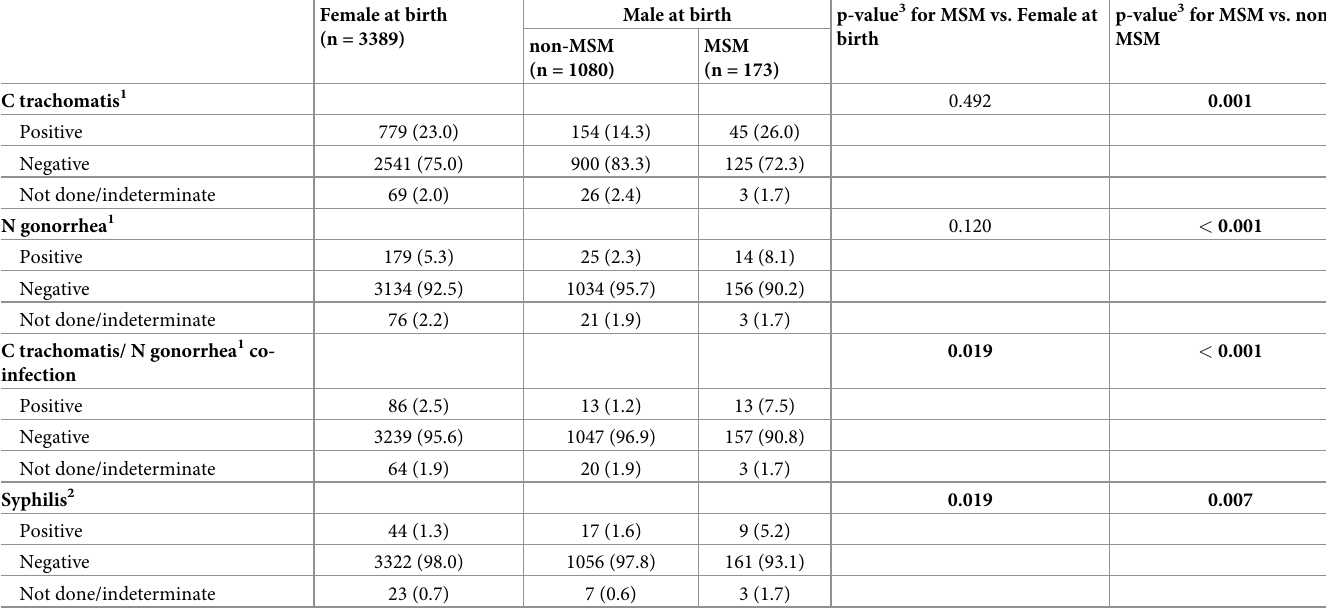
Table 3. Baseline (month 0) STI testing results for females at birth, non-MSM males at birth and MSM who had data